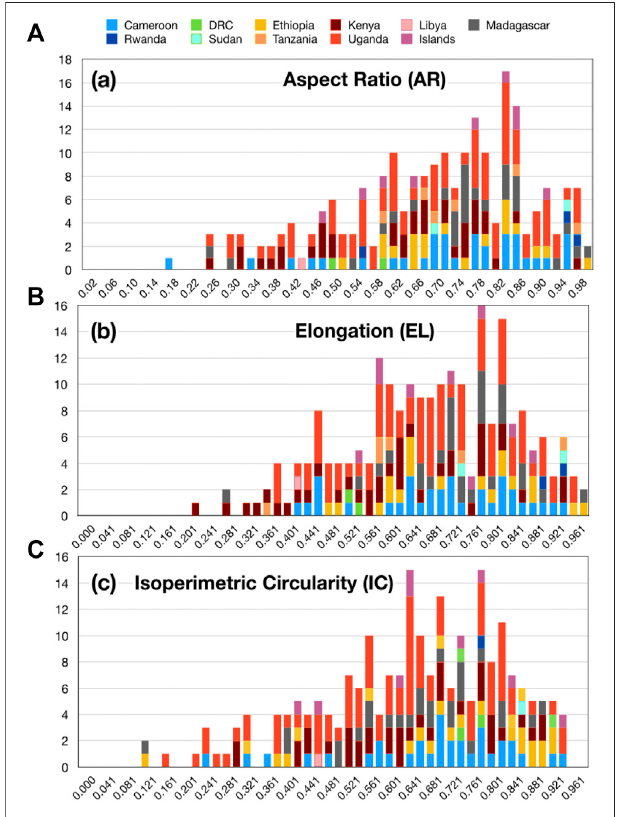
FIGURE9| Histogramsofparametersforthe220Africanvolcaniclakes: (A) elevation (in m a.s.l.), and (B) maximum diameter (in m).